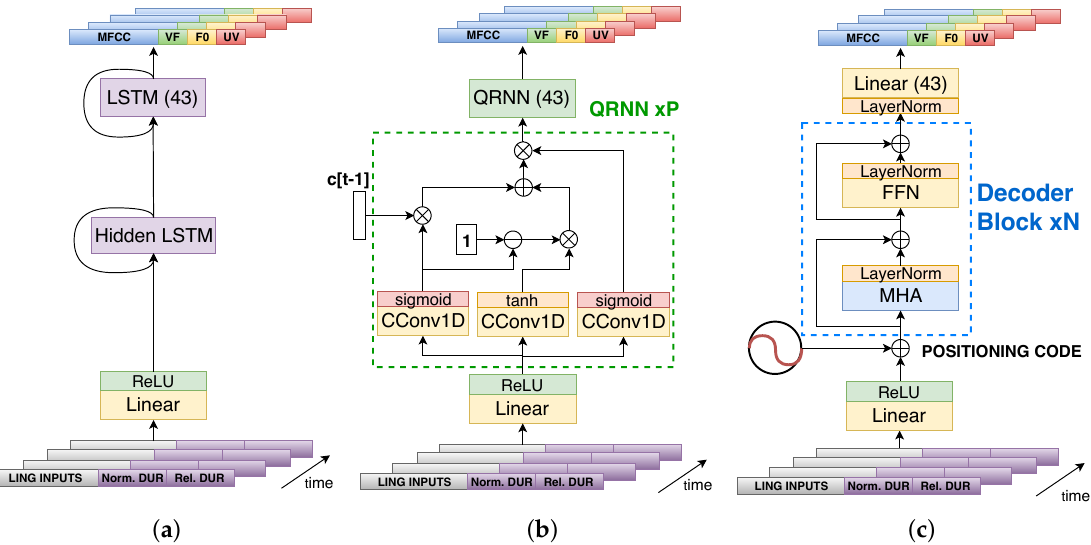
Figure 1. Comparison of architectures for: ( a ) RNN/LSTM acoustic model; ( b ) QLAD; and ( c ) SALAD acoustic model. The embedding projections are the same. The QRNN block is stacked P times in the hidden layers. In SALAD, the positioning encoding introduces sequential information. The SALAD decoder block is stacked N times to form the hidden structure. FFN, Feed-forward Network; MHA, Multi-Head Attention; CConv1D, Causal 1D